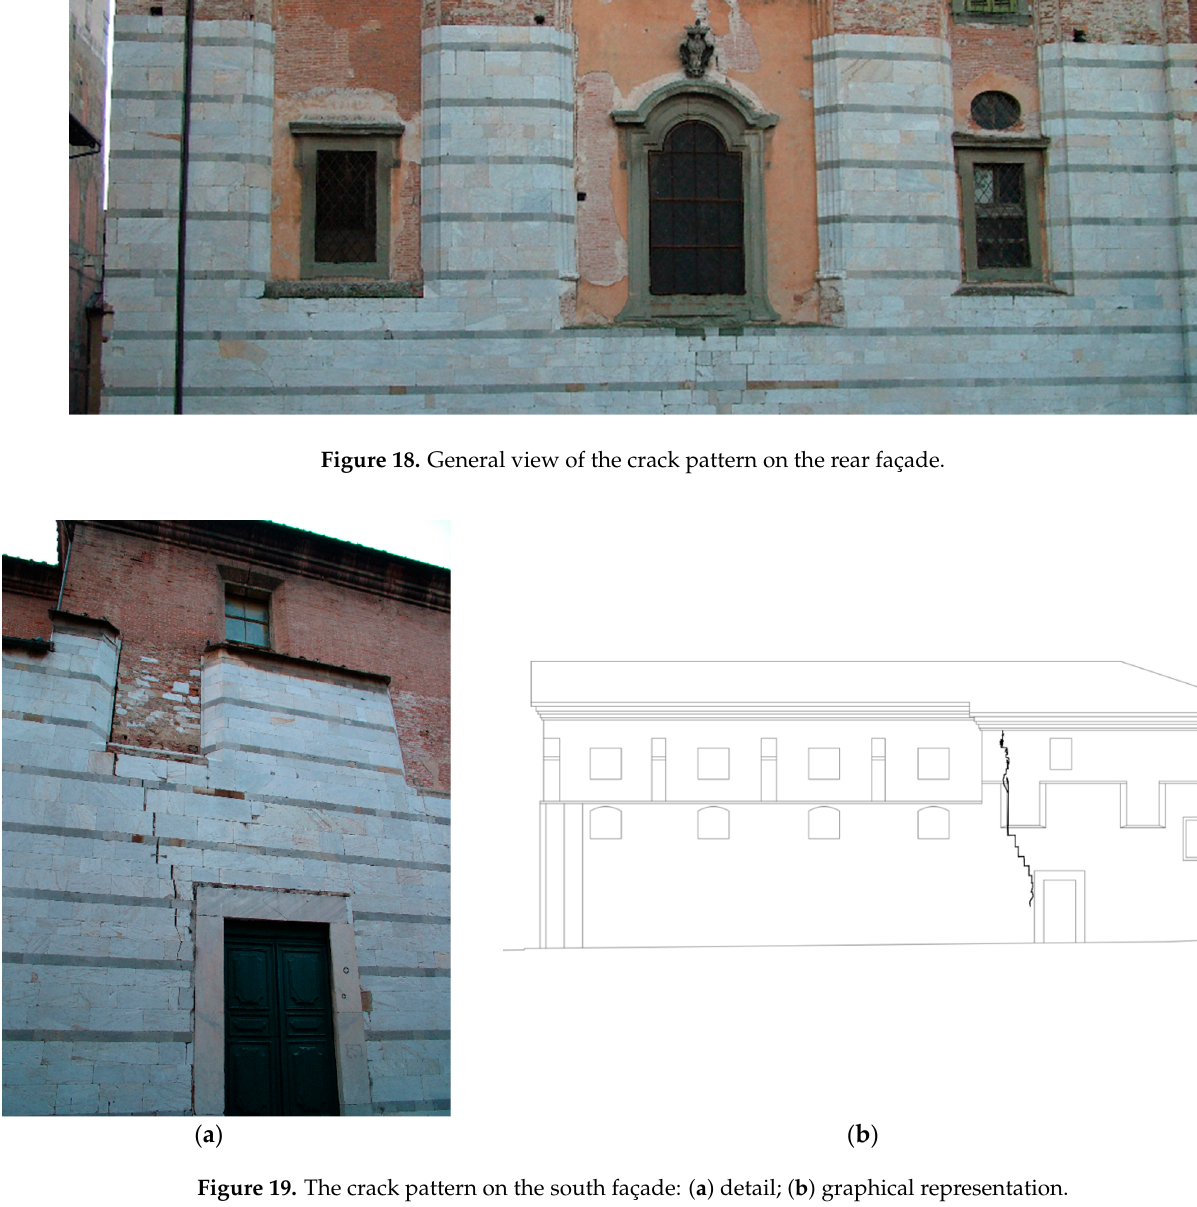
Figure 19. The crack pattern on the south façade: ( a ) detail; ( b ) graphical representation.